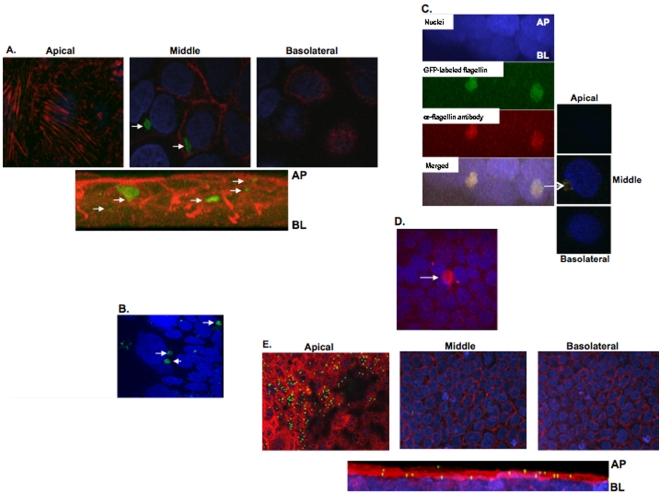
Flagellin monomers were internalized by polarized IEC.Note: White arrows in A-D indicate cluster of flagellin monomers. A. GFP-labeled flagellin monomers (green) were internalized by Caco-2BBe cells at 30 min post-AP exposure and visualized via confocal microscopy. The cell body was visualized by staining for F-actin using phalloidin (red). Accumulated flagellin was detected inside the cells as shown in the mid z-sections taken by confocal microscopy. A transverse image reconstruction from optical z-stacks is shown below and shows flagellin below the cell surface. B. GFP-labeled flagellin was added to the AP surface of polarized T-84 cells and 30 min post-exposure flagellin clusters could be detected within the cell body from mid z-sections taken by confocal microscopy using a 60x objective lens. Cell nuclei were stained by DAPI (blue). C. Caco-2 BBe cells internalized GFP-labeled flagellin (green) which was also immunostained using a rhodamine rabbit anti-flagellin antibody (red). Co-localization GFP and rhodamine signals is seen in the merged images and in the transverse image reconstruction from z-stacks taken by confocal microscopy (at right). D. Flagellin purified from S. Typhimurium was internalized by Caco-2BBe cells. Intracellular staining of purified S. Typhimurium flagellin were visualized, via the middle z-section taken by confocal microscopy after 30 min of apically applied flagellin using a rabbit anti-flagellin antibody followed by a secondary anti-rabbit antibody conjugated to rhodamine (red). Cell nuclei were stained with DAPI (blue) E. Optical z-sections showing apical and basolateral surfaces as well as the middle plane through the cells together with a transverse image reconstructed from z-stacks showing lack of uptake of latex beads (MW 40,000; green) by Caco-2BBe cells after a 30 min incubation. F-actin was stained using phalloidin (red) and cell nuclei were stained with DAPI (blue). Images were acquired using a 60X objective lens. The confocal images shown are representative of 1 of 4 experiments producing similar results.